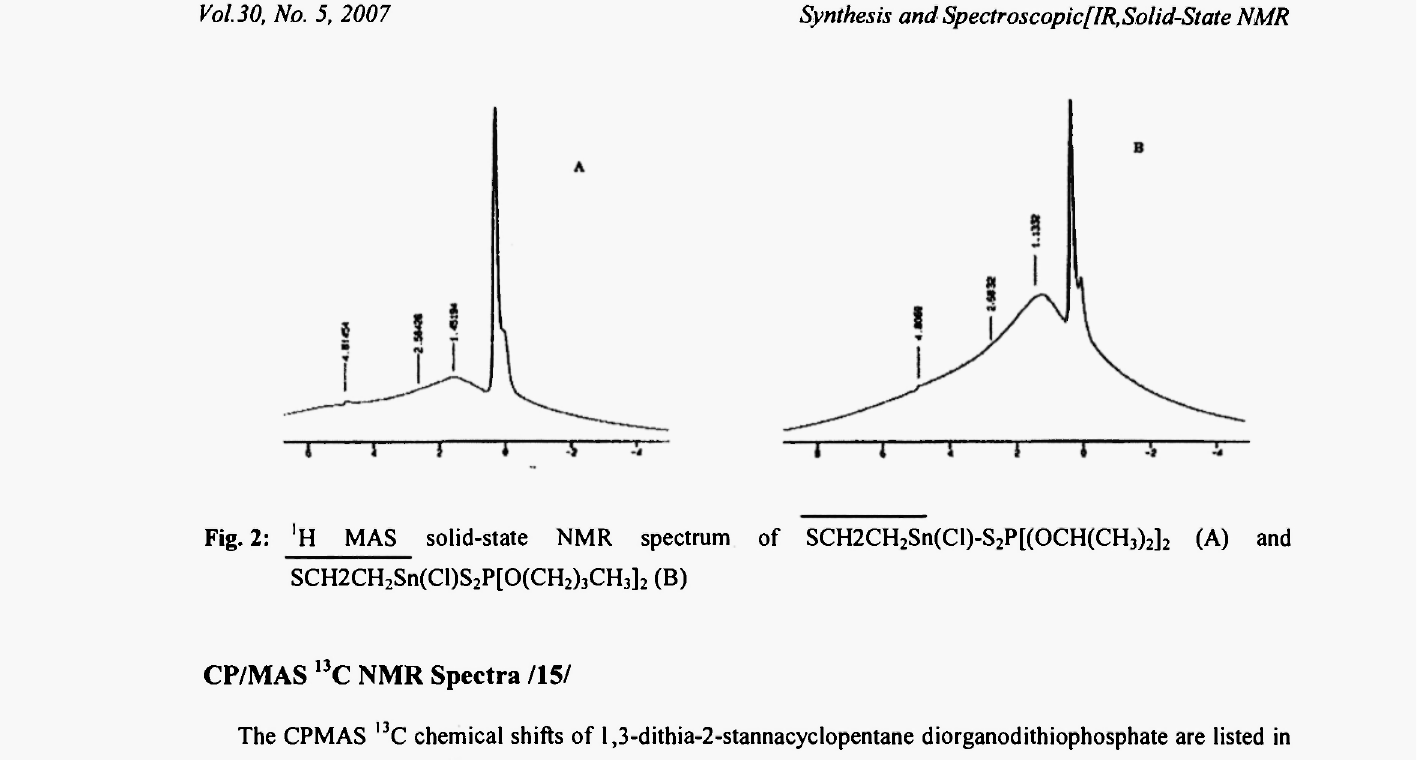
CP/MAS 13 C NMR Spectra /15/ The CPMAS 13 C chemical shifts of l,3-dithia-2-stannacyclopentane diorganodithiophosphate are listed in Table 3. In the CPMAS l3 C NMR spectra of ethyl, η-propyl, /'-propyl and «-butyldithiophosphate derivatives, the presence of a characteristic sharp signal of the carbons on the ethane-l,2-dithiolato group has been observed in the region 34.93-39.23 6ppm, due to magnetically equivalent CH 2 S ring carbons. For the solution NMR data of the l,3-dithia-2-stannacyclopentane diorganodithiocarbamates /26/, SCH 2 carbons were observed in the region 33.9-35.9 5ppm. From the above observation, except diethyldithiophosphate complex, the solid state SCH 2 carbons were observed downfield in l,3-dithia-2-stannacyclopentane diorganodithiophosphate complexes. In addition, these compounds also show that expected carbon resonances are due to ethyl, «-propyl, /-propyl and «-butyl dithiophosphate moieties. The diethyldithiophosphate derivative (7 in Table 1) shows signals at 16.59 and 64.18 5ppm, due to CH 3 and OCH 2 carbon resonances, respectively. The n-propyldithiophosphate complex (8 in Table 1) shows signals at 10.74, 23.93 and 70.30 5ppm, due to CH 3 , CH 2 & OCH 2 carbon resonances, respectively. The /'- propyldithiophosphate derivatives (3 and 9 in Table 1) show signals in the regions 27.58-27.77 and 74.33- 74.60 5ppm due to methyl and OCH carbons, respectively. The «-butyldithiophosphate derivatives (4 and 10 in Table 1) show signals in the regions 16.93-17.08, 21.97-22.10, 35.13-35.34 and 72.07-74.33 5ppm, due to CH 3 , CH 2 (γ), CH 2 (β) and CH 2 (a) protons, respectively. The chemical shift values for carbons of diorganodithiophosphate moieties were observed downfield in solid-state as compared to the solution state.